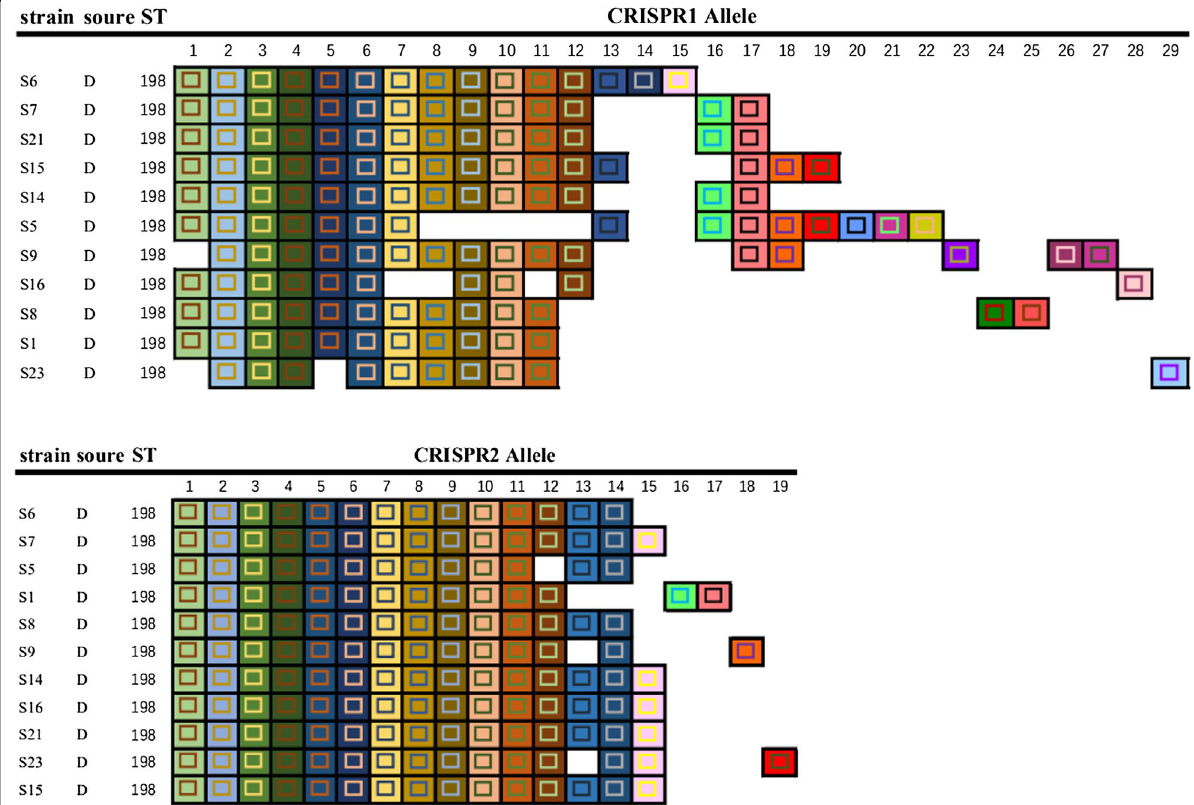
Fig. 2 Graphic representation of spacers across the two CRISPR loci for a variety of Salmonella Kentucky strains. Repeats are not included; only spacers are represented. Each spacer is represented by a combination of a character in a particular font colour, on a particular background colour. The colour combination allows each spacer to be uniquely represented, whereby squares with similar colour schemes (combination of character colour and background colour) represent identical spacers and different colour combinations represent distinguishable spacers. The spacers are aligned, and the gaps represent the absence of a particular spacer. Above, CRISPR1; Below,